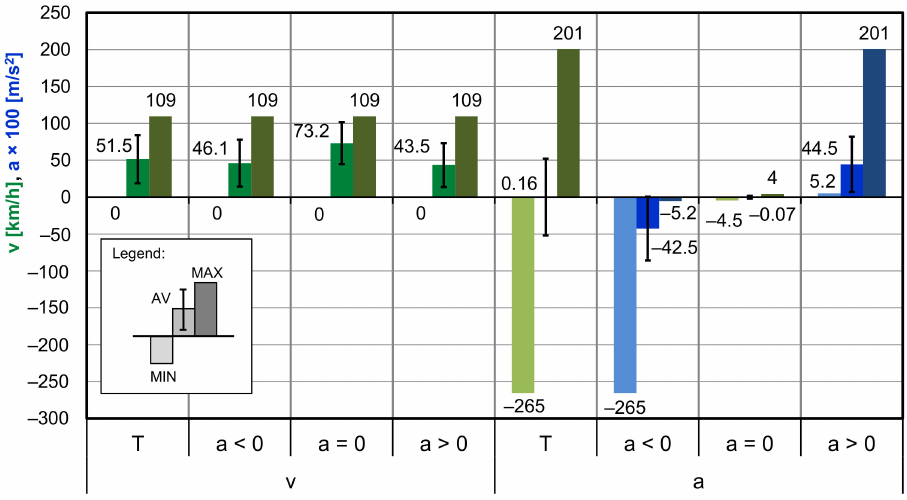
Figure 6. Zero-dimensional characteristics of the process of vehicle velocity and acceleration for the models of engine operating states and for the entire test.